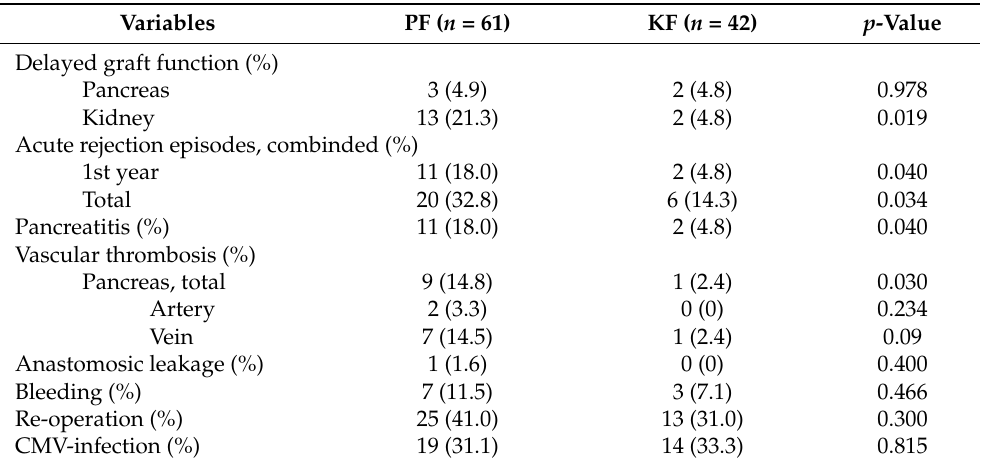
Table 2. Postoperative complications after simultaneous pancreas-kidney